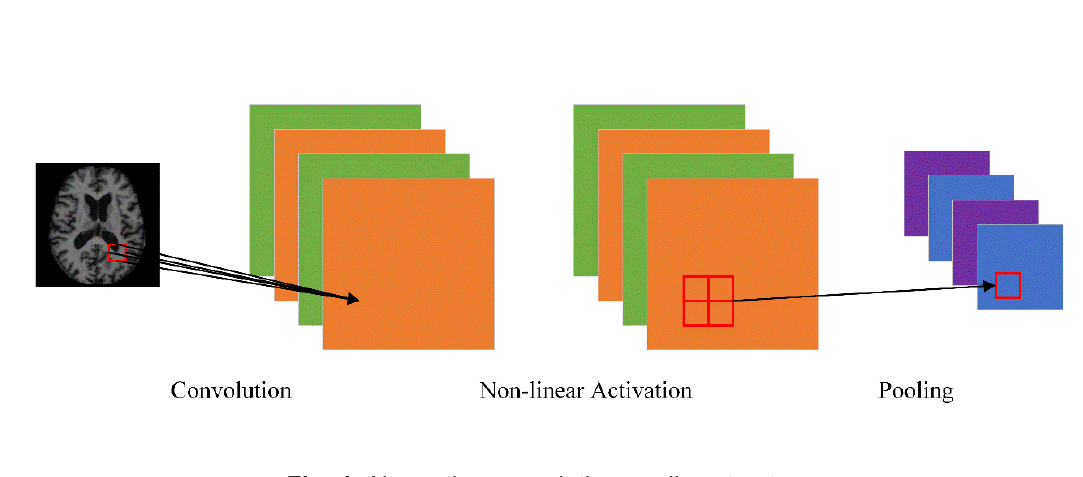
Fig. 4. Alternating convolution-pooling structure